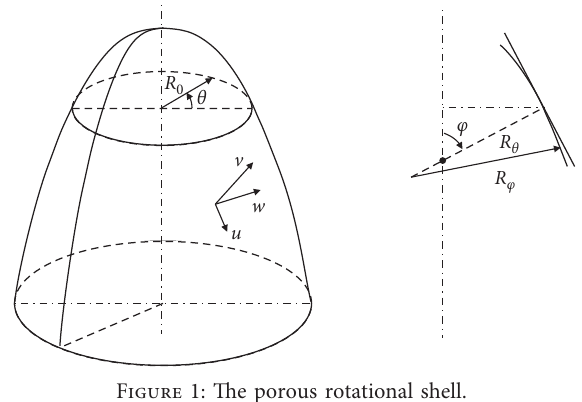
Figure 1: The porous rotational